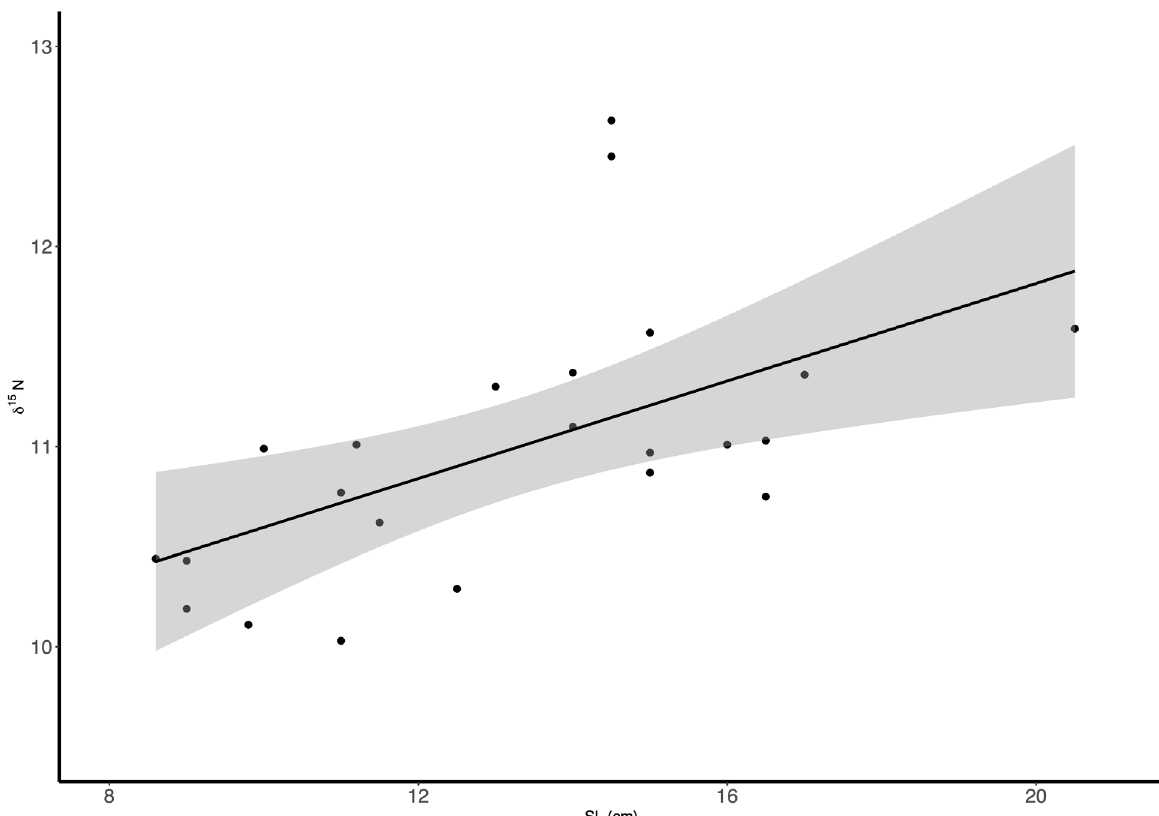
Figure 2. Relationship between standard length (SL) and raw values of δ 15 N in the non-native piranha Serrasalmus marginatus ( R = 0.53; t = 2.97; p < 0.01). Grey shading around the regression line indicates the 95% confidence